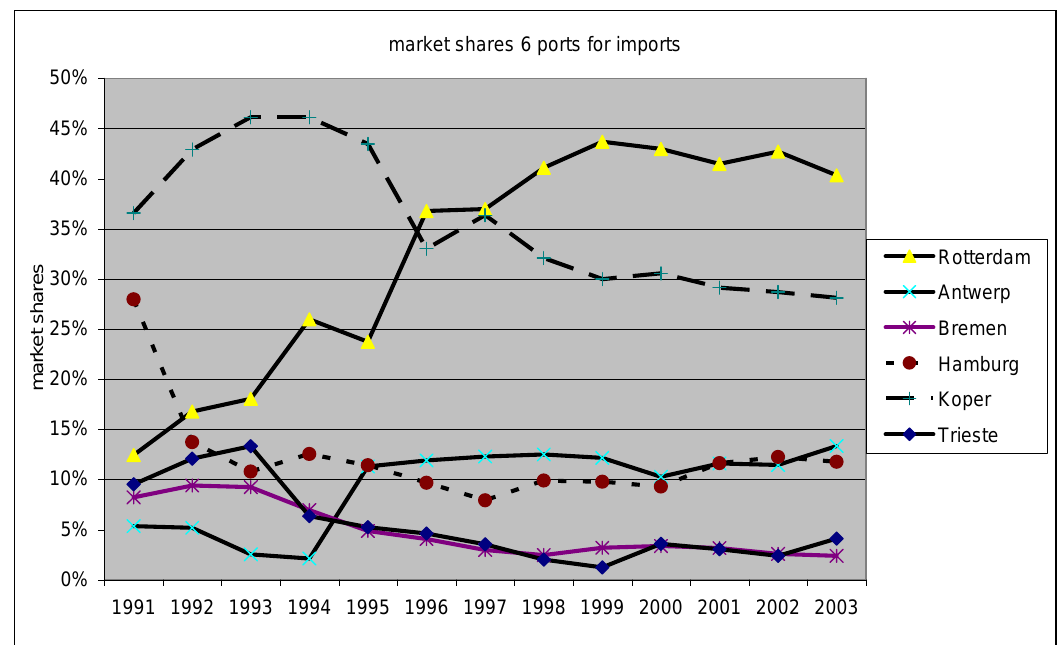
Figure 3. Market shares of ports for Austrian imports